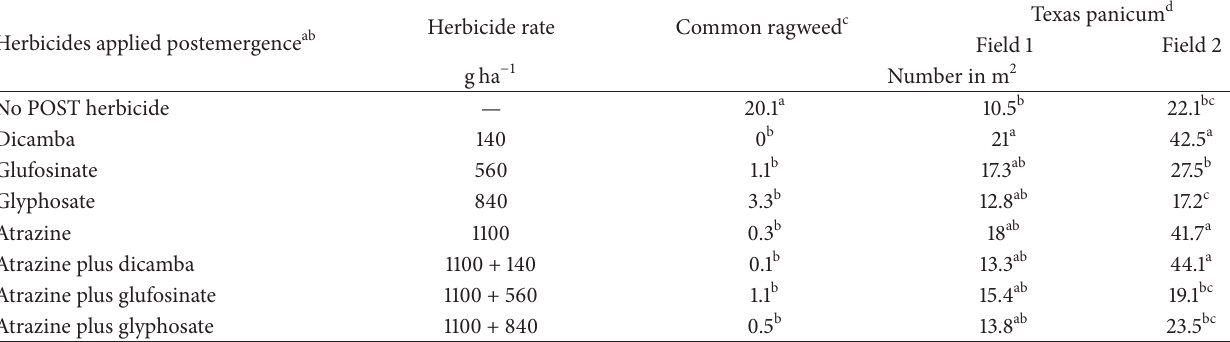
Table 2: Common ragweed and Texas panicum densities 6 weeks after treatment as influenced by herbicide program during 2012 at Lewiston-